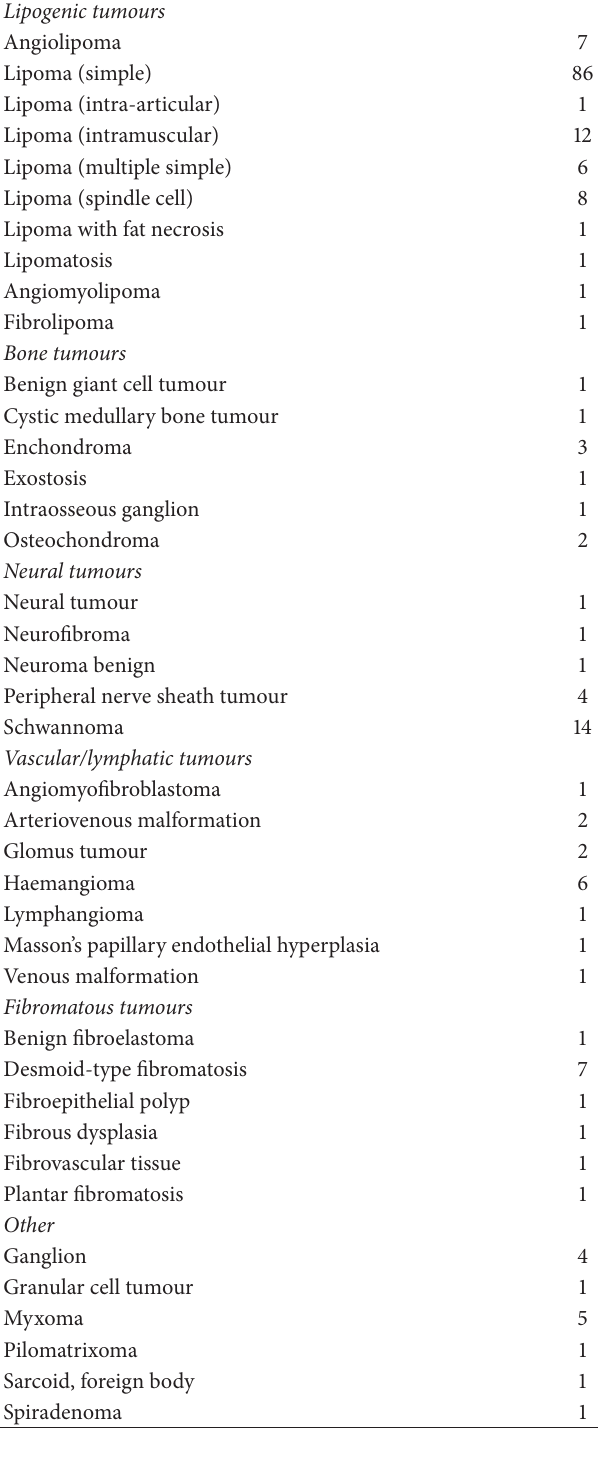
Table 3: Diagnostic distribution of benign